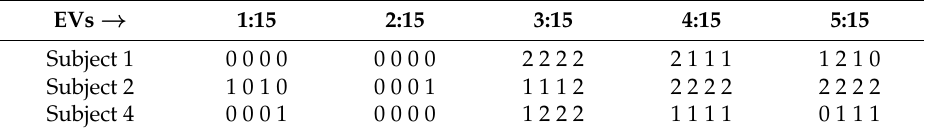
Figure 10. Mean diffuse reflectance data across the three time stamps for subject 1. The error bars show the standard deviation across the 17 averaged locations. The numbers 0, 1, and 2 represent the success counter of the hypotheses, stating whether diffuse reflectance was not significant ( H = 0), significant across one pair of stimuli ( H = 1), or significant across both pairs of stimuli ( H = 2). Table 2. Resulting hypotheses (from four repetitions on data analysis) in response to occlusion across subjects 1, 2, and 4 when using EVs 1:15 to 5:15.